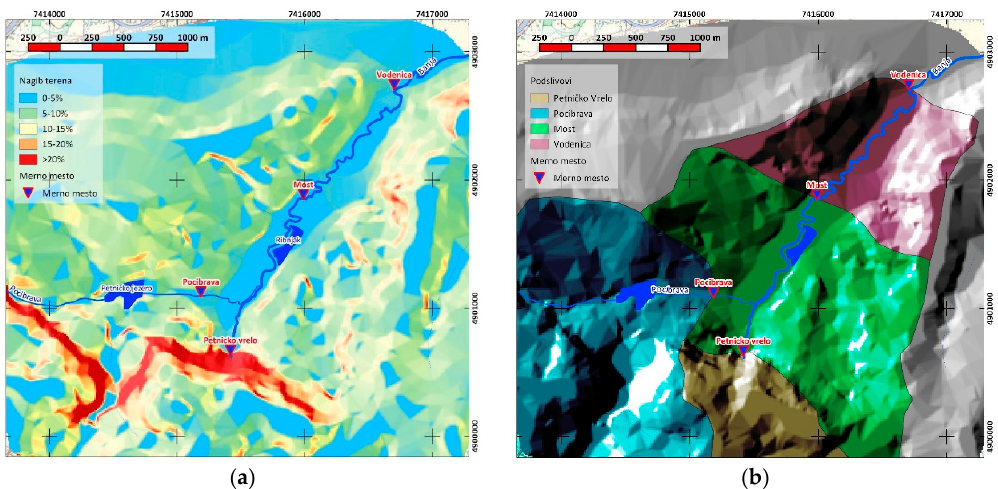
Figure 5. ( a ) Slope analysis on research area; ( b ) A map of defined sub-basins within Banja River catchment area on research